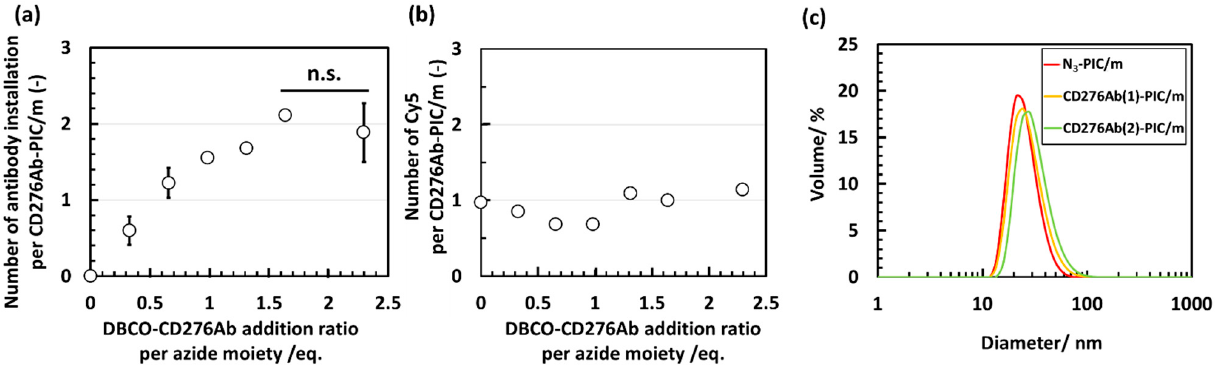
Figure 4. Characterization of CD276Ab-PIC/m after introducing CD276Ab by conjugating DBCO- CD276Ab to N 3 -PIC/m through click reaction at di ff erent addition ratios per azide moiety. ( a ) Number of antibodies installed to N 3 -PIC/m calculated from the counts per molecule obtained via FCS measurement (N = 3). Statistical analysis was conducted through Student’s t -test and n.s. indicates p > 0.05. Data are shown in average ± standard deviation. ( b ) Number of Cy5s per CD276Ab-PIC/m evaluated to check for aggregations. Representative size distribution was measured from ( c ) DLS measurement.